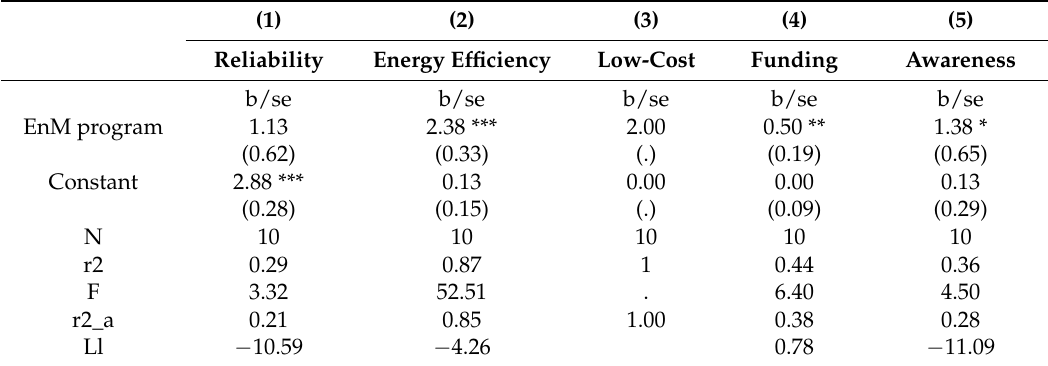
Table 4. Regression Model (B) a